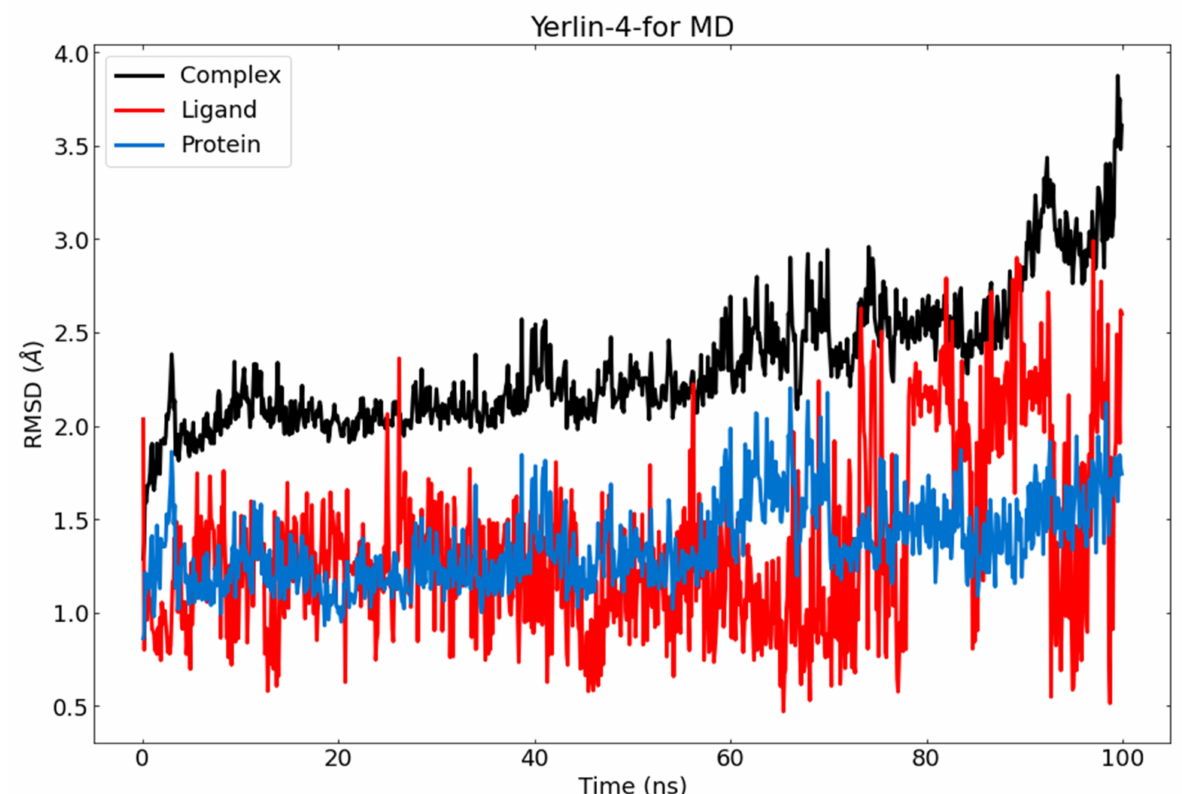
Figure 13. RMSD value of jusan coumarin in MD runs. Red: jusan coumarin; blue: M pro ; black: M pro -jusan coumarin